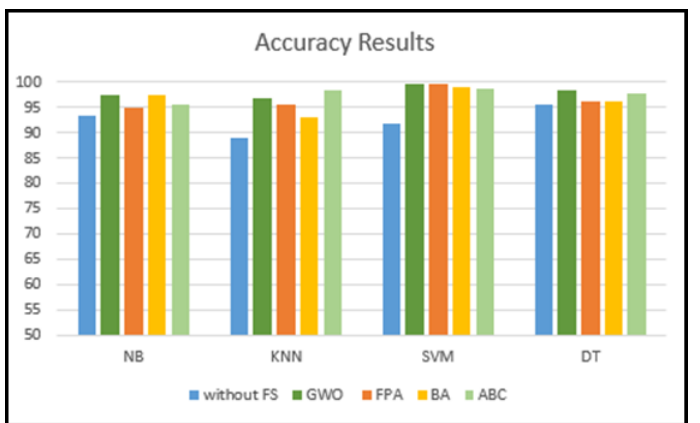
Figure 9. Comparison of accuracy between Experiment 1 and Experiment 2 on the PBC dataset.